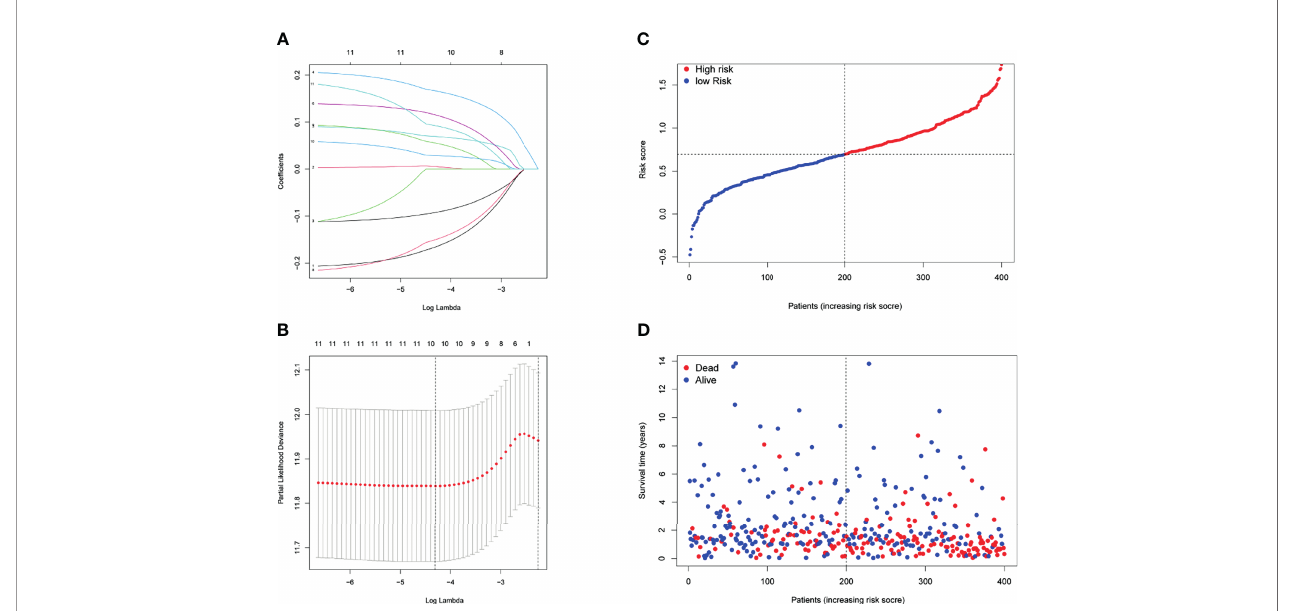
FIGURE 3 | Prognostic analysis of the 10-gene signature model in the TCGA cohort. (A) LASSO coef fi cient expression pro fi les of 13 candidate genes. (B) The penalty parameter ( l ) in the LASSO model was selected through 10 cross-validation. (C) The median value and distribution of the risk scores. (D) The distribution of OS status.